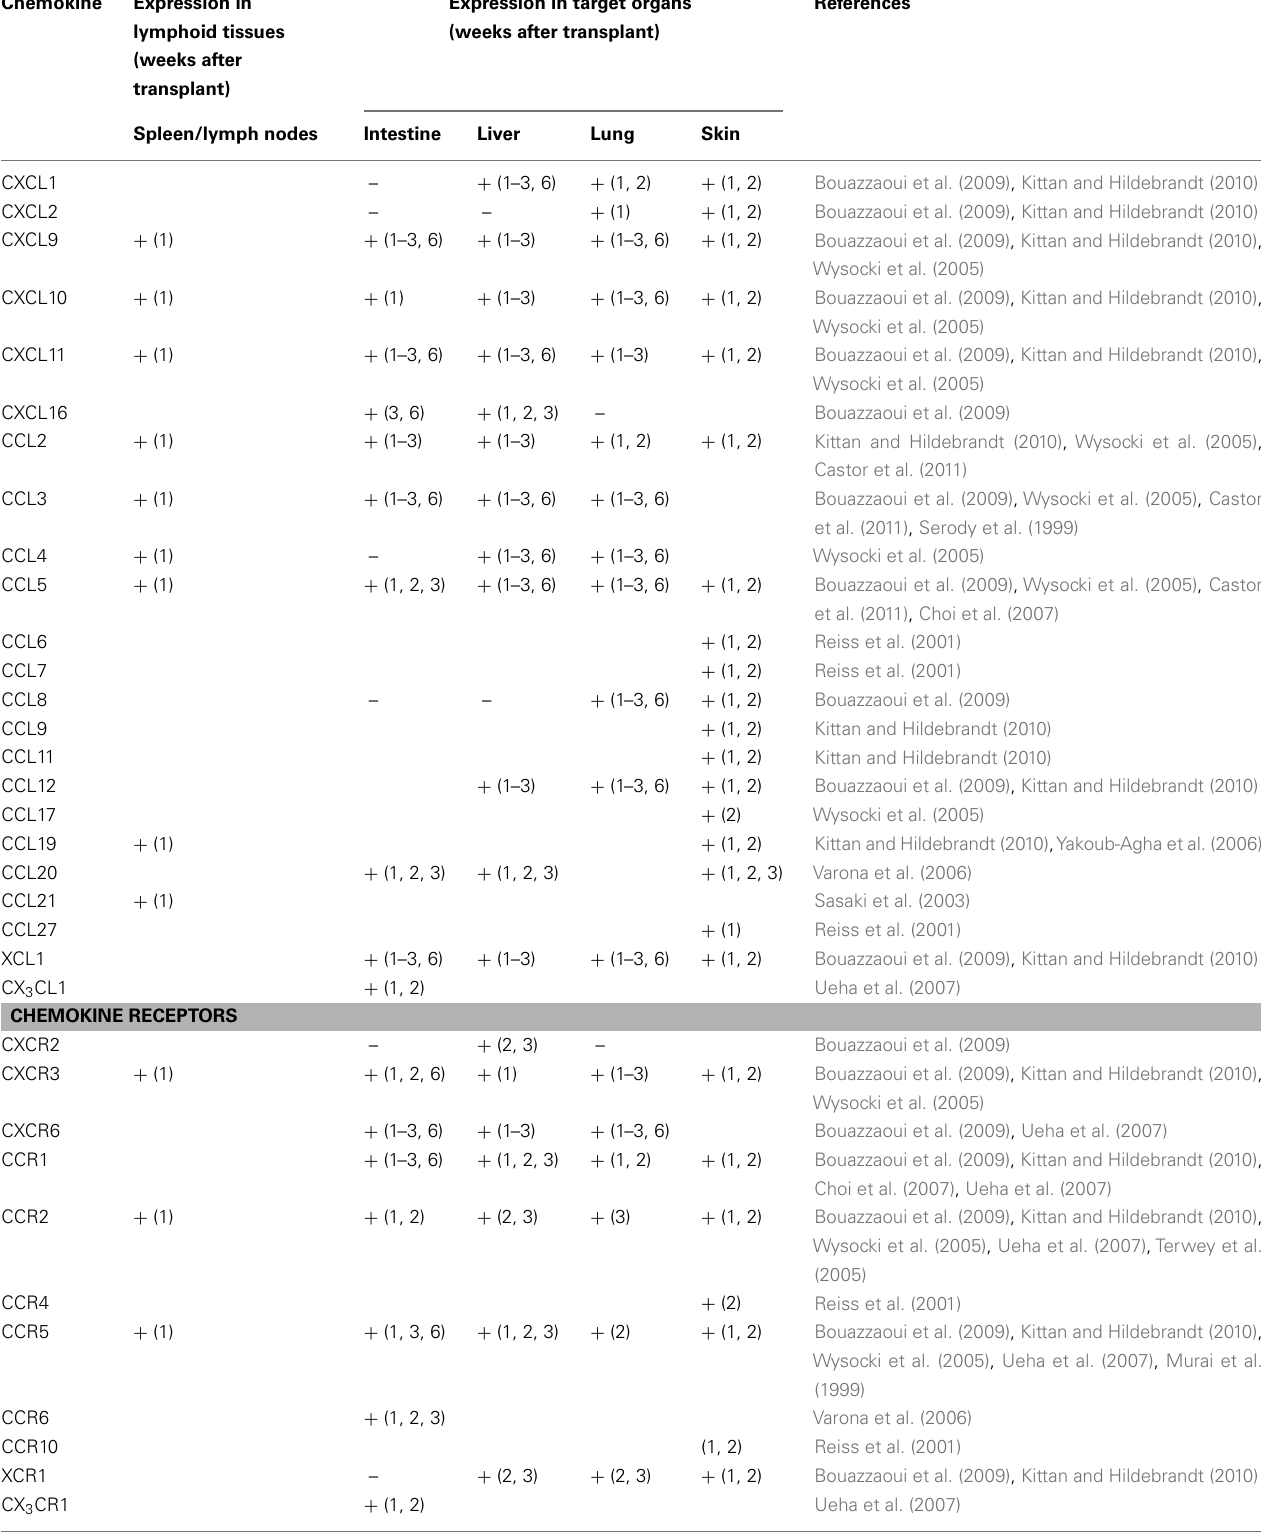
Table 2 | Chemokine and chemokine receptor expression in acute GVHD.